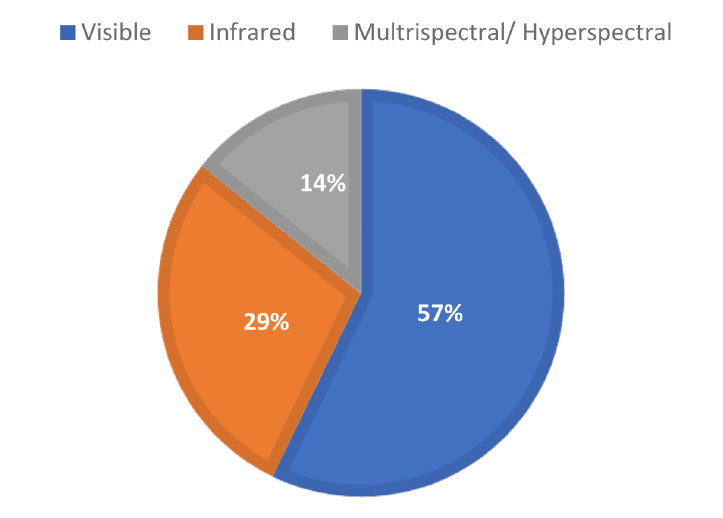
Figure 8. The total percentages of cameras per type used in the applications.